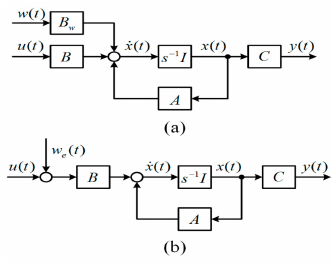
Figure 4. The concept of equivalent input disturbance, ( a ) original plant; ( b ) plant with